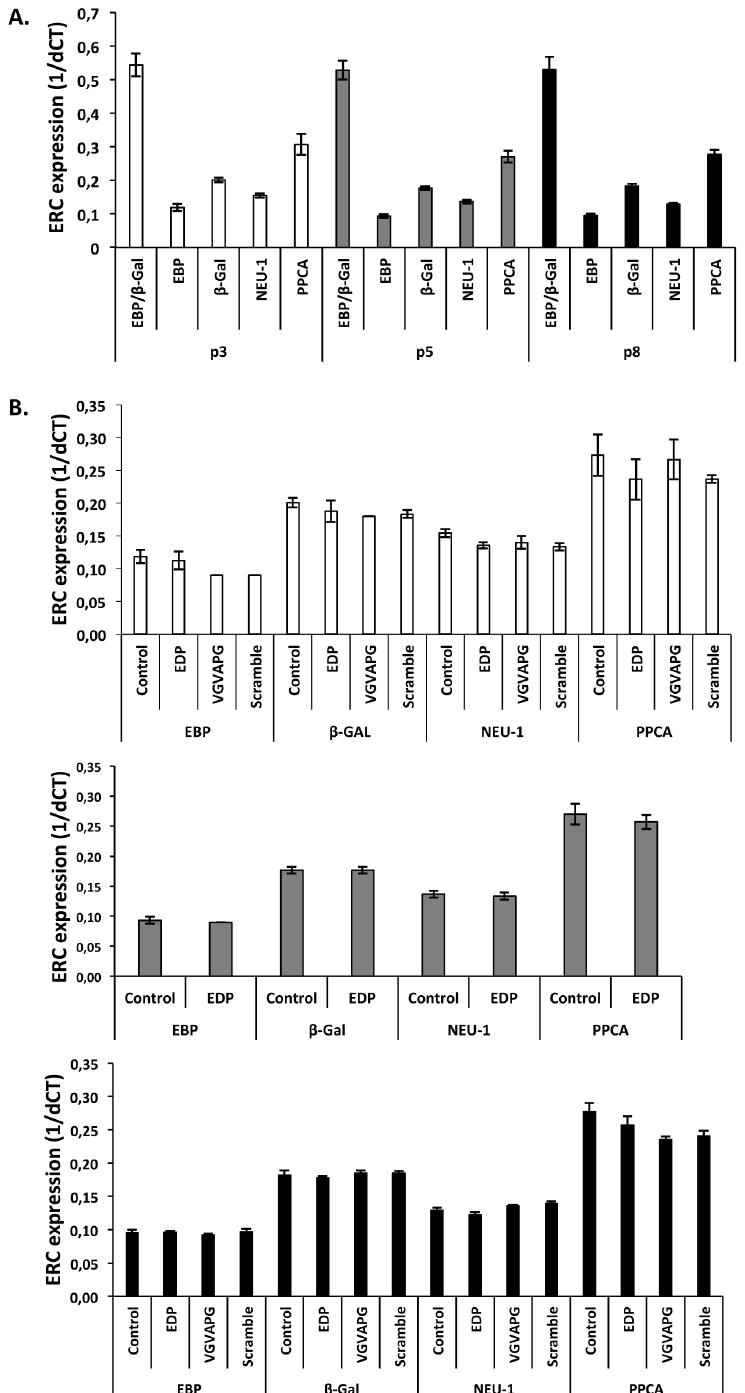
Fig 3. mRNA expression analysis of the three subunits of the elastin complex receptor during in vitro aging. Young, intermediate and aged fibroblasts were represented by passage 3 (white), 5 (gray) and 8 (black bars). (A) mRNA expression of EBP, NEU-1 and PPCA during in vitro aging. (B) Impact of EDP on ERC subunits expression during in vitro aging. mRNA levels were analyzed after 24 hours of stimulation with 50 μ g/mL of EDP or 200 μ g/mL of scramble or VGVAPG peptides. Results are expressed as 1/dCT. Each data are representative of three independent experiments. No significant differences were